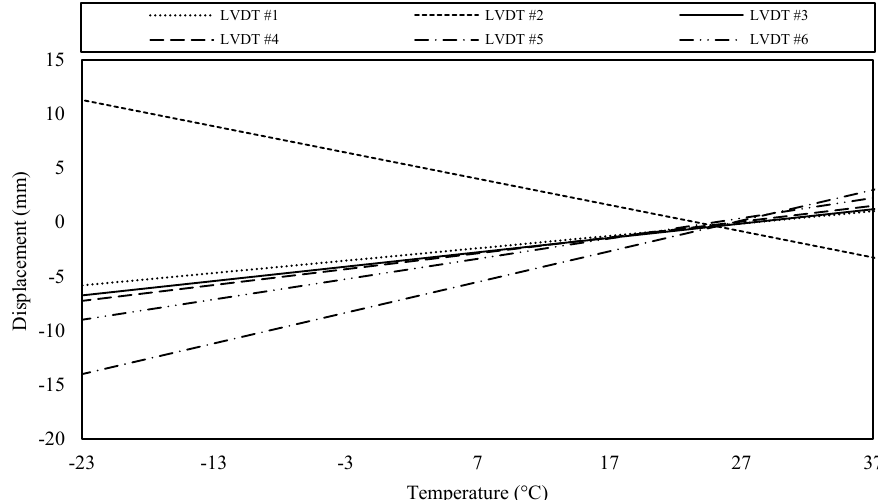
Figure 9. Measured temperatures and displacements ( a ) cold weather longitudinal displacement ( b ) cold weather lateral displacement.